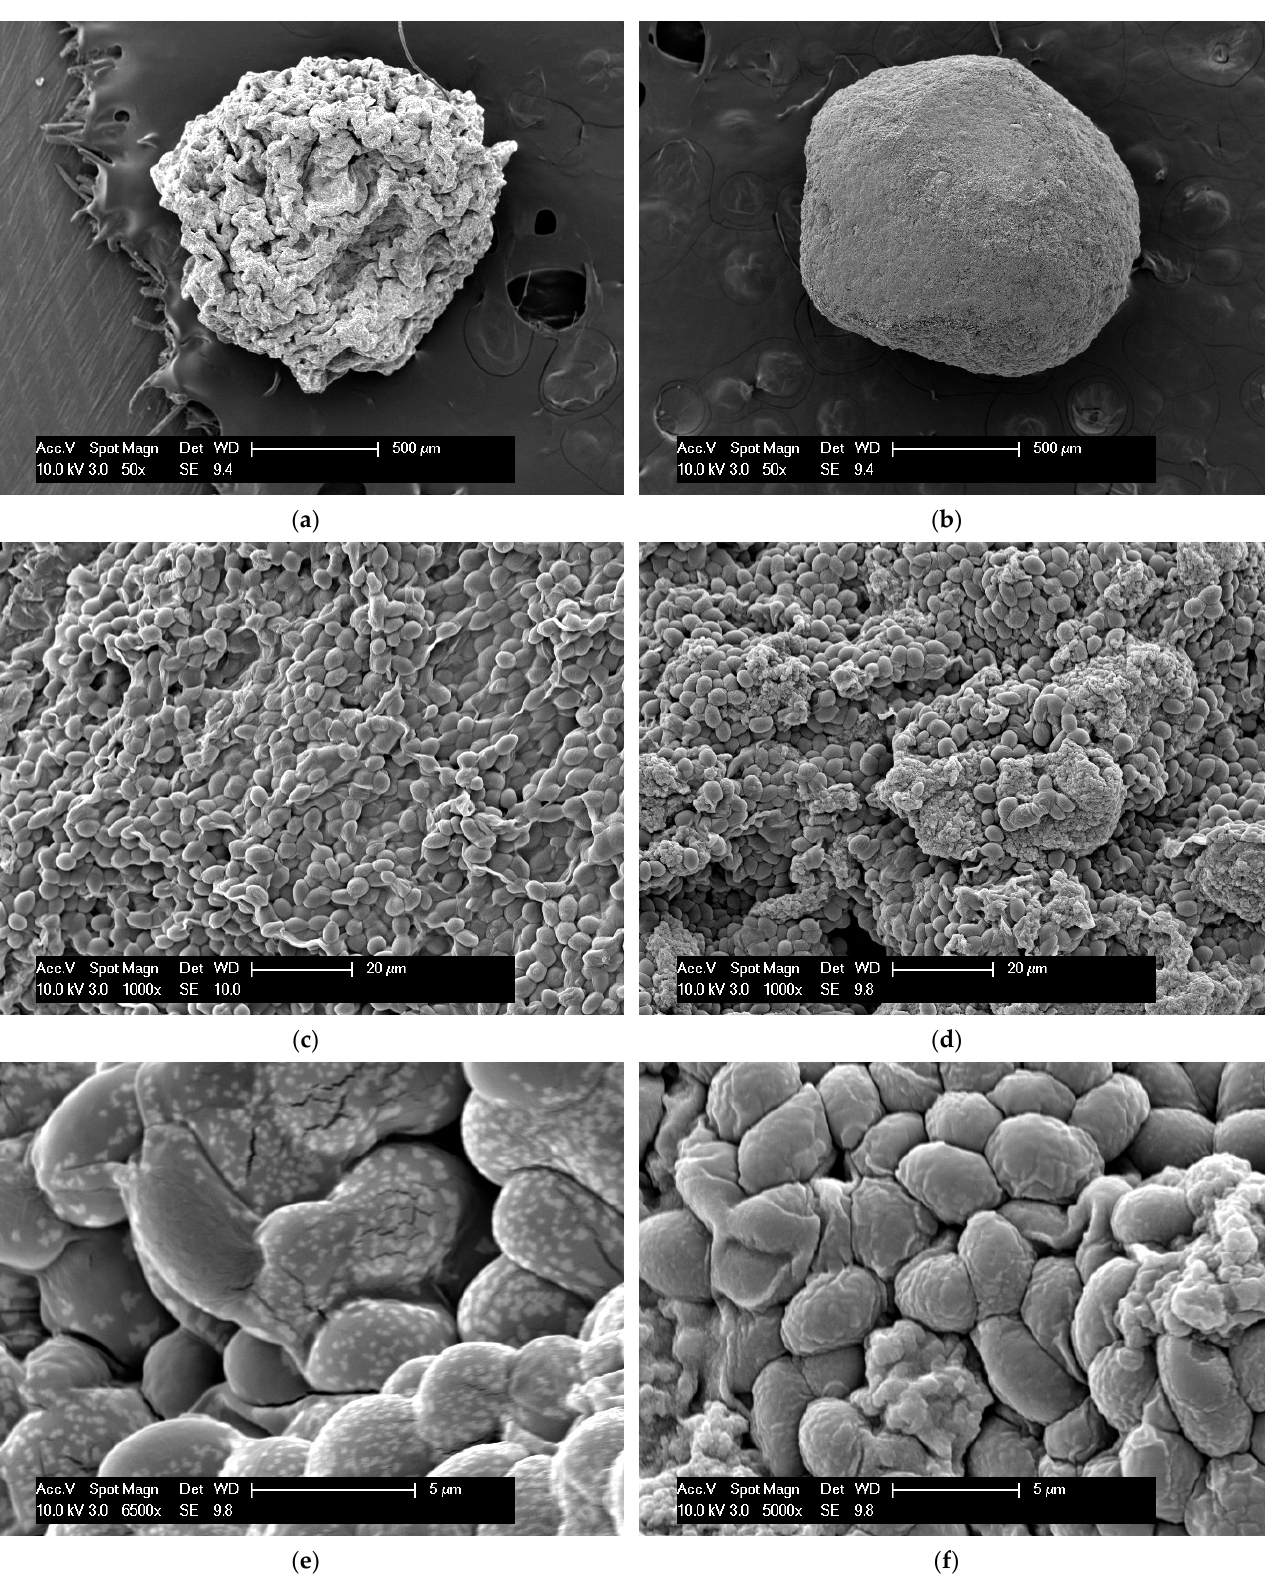
Figure 4. Scanning Electron Microscopy (SEM) of T18 yeast encapsulated in Ca-alginate beads ( a , c , e ) and Ca-alginate/chitosan beads ( b , d , f ).